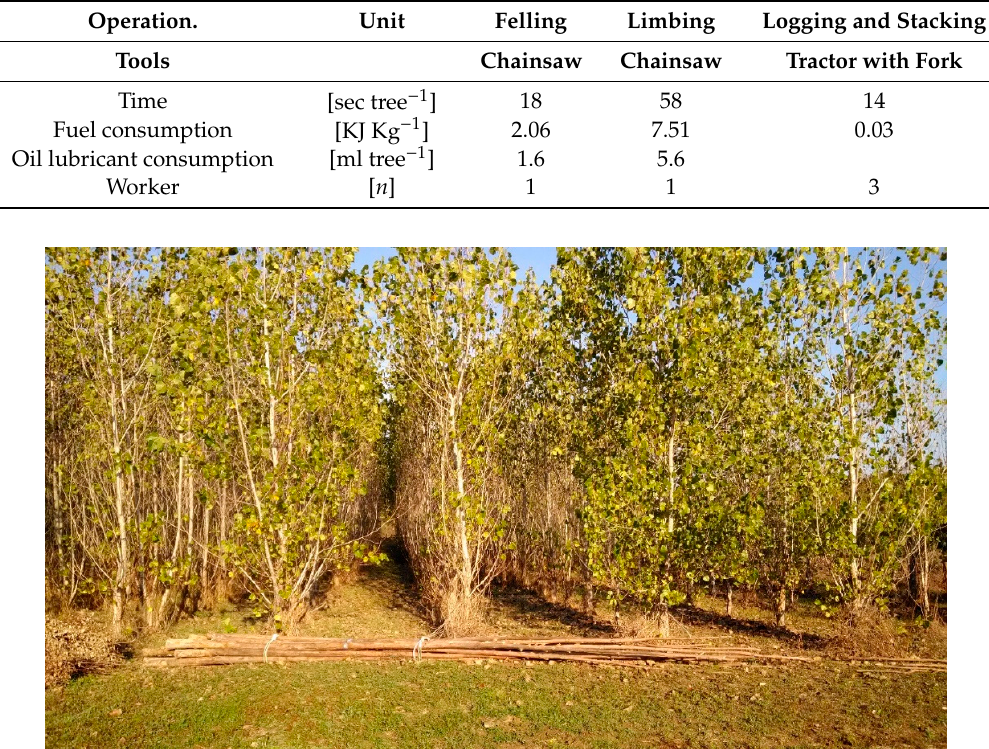
Figure 2. Eucalyptus whole-stem storage without branches (WS).